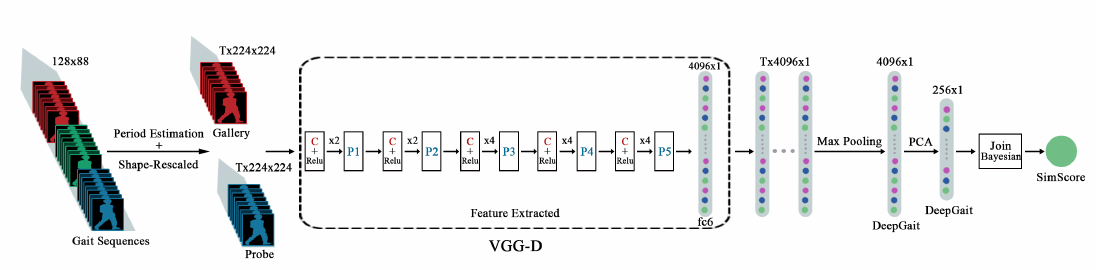
Figure 1. An illustration of the proposed gait recognition process. (C: convolution, P: max-pooling, T: gait